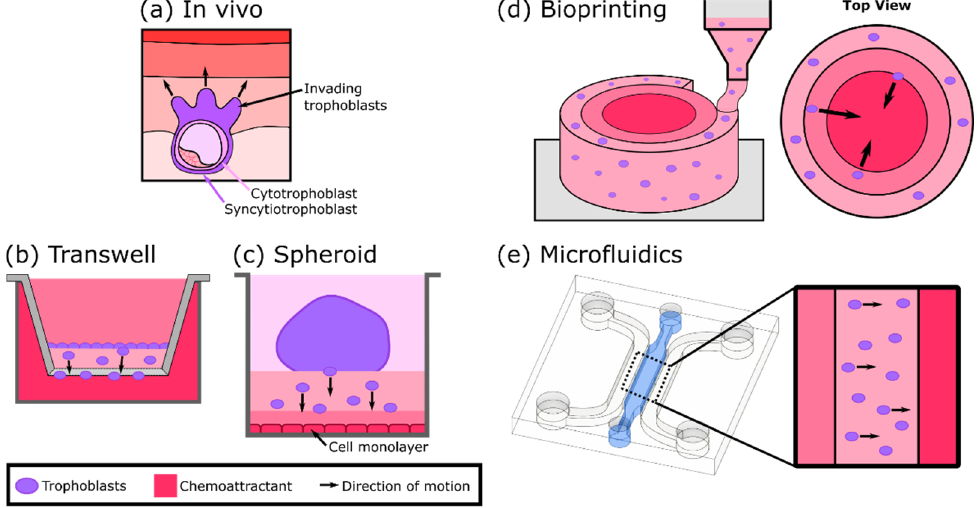
Figure 3. Summary of trophoblast invasion models. ( a ) Diagram of trophoblast invasion of the endometrium in vivo. ( b ) A transwell model with a monolayer of trophoblasts invading a gel towards the chemoattractant in the well (based on designs in [32–35]). ( c ) A spheroid model in a well plate with trophoblasts invading the underlying gel towards a monolayer of cells (based on design in [36]). ( d ) A bioprinted model consisting of concentric rings of a gel, with trophoblasts in the outermost layer and a chemoattractant in the innermost layer (based on designs in [37–39]). ( e ) A microfluidic device with trophoblasts suspended in a gel in the center channel with medium flowing through the channels on either side (based on design in [40,41]). The chemoattractant is included in only one media channel in this design.